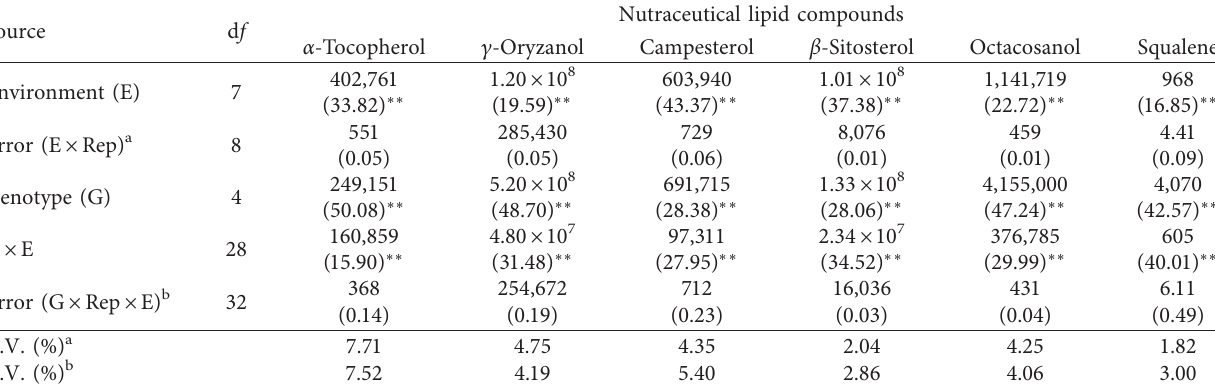
Table 3: Combined analysis of variance for nutraceutical lipid contents of five pigmented rice genotypes evaluated across eight envi- ronments, 2017-2018.